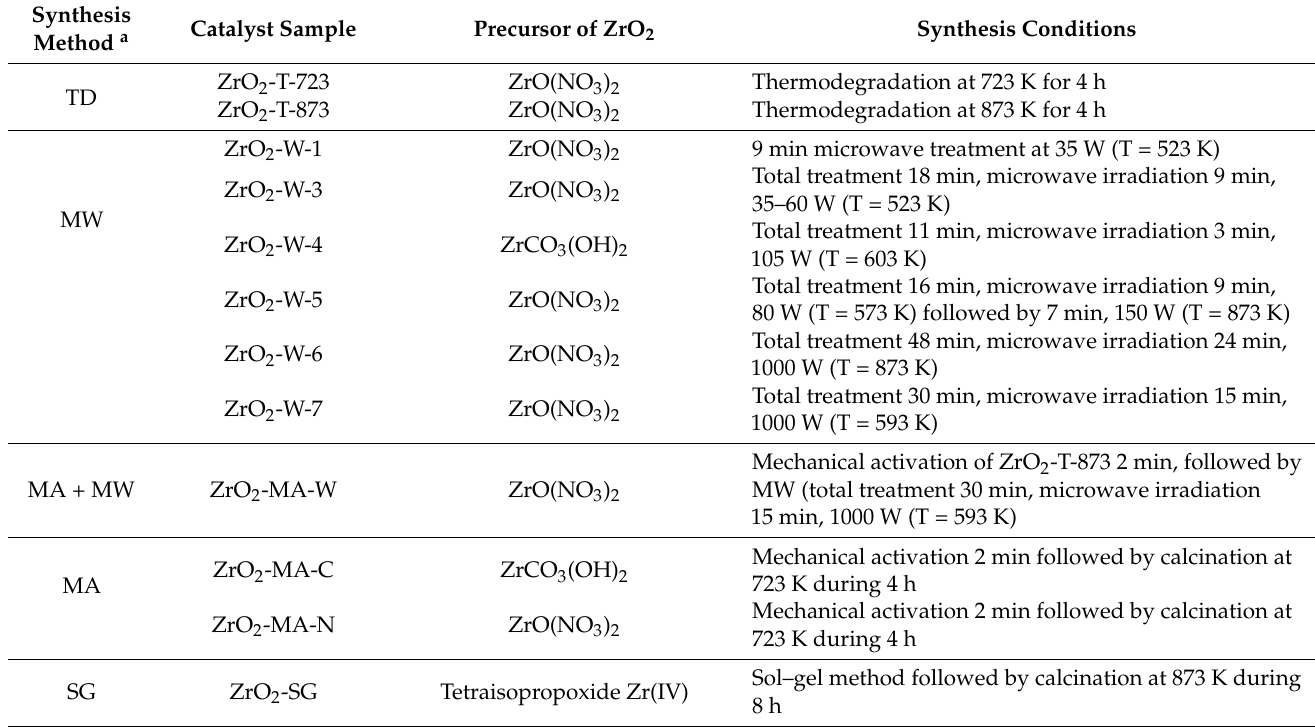
Table 2. Synthesis of ZrO 2